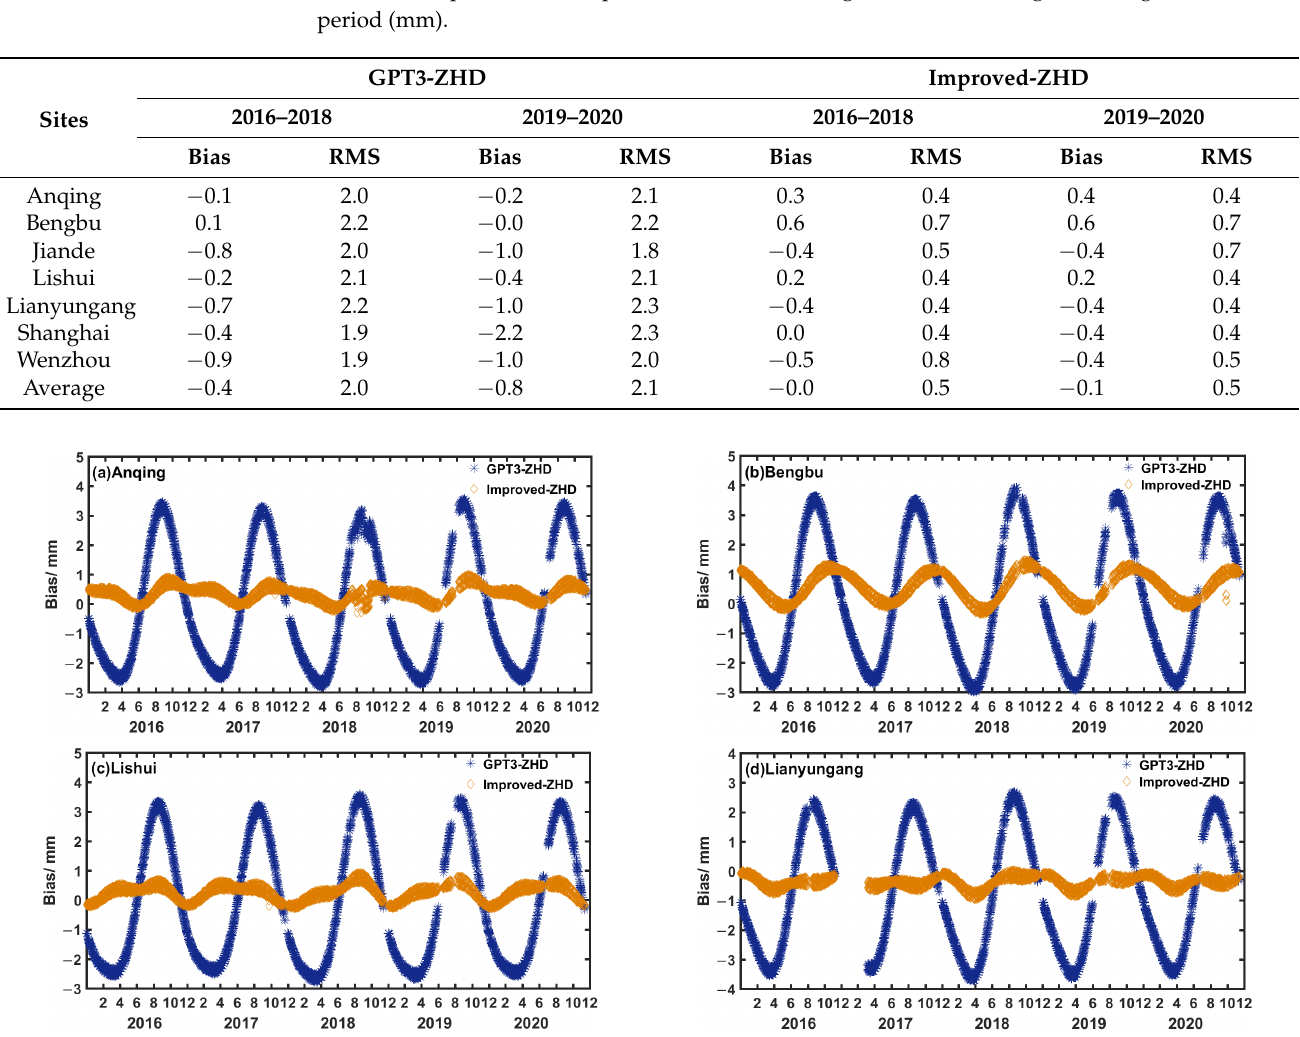
Figure 4. The bias of improved-ZHD and GPT3-ZHD at Anqing ( a ), Bengbu ( b ), Lishui ( c ), and Lianyungang ( d ) during the 2016–2020 period. Table 3. Fourier coefficients of the GPT3- T m bias in the Yangtze River Delta region during the 2016–2018